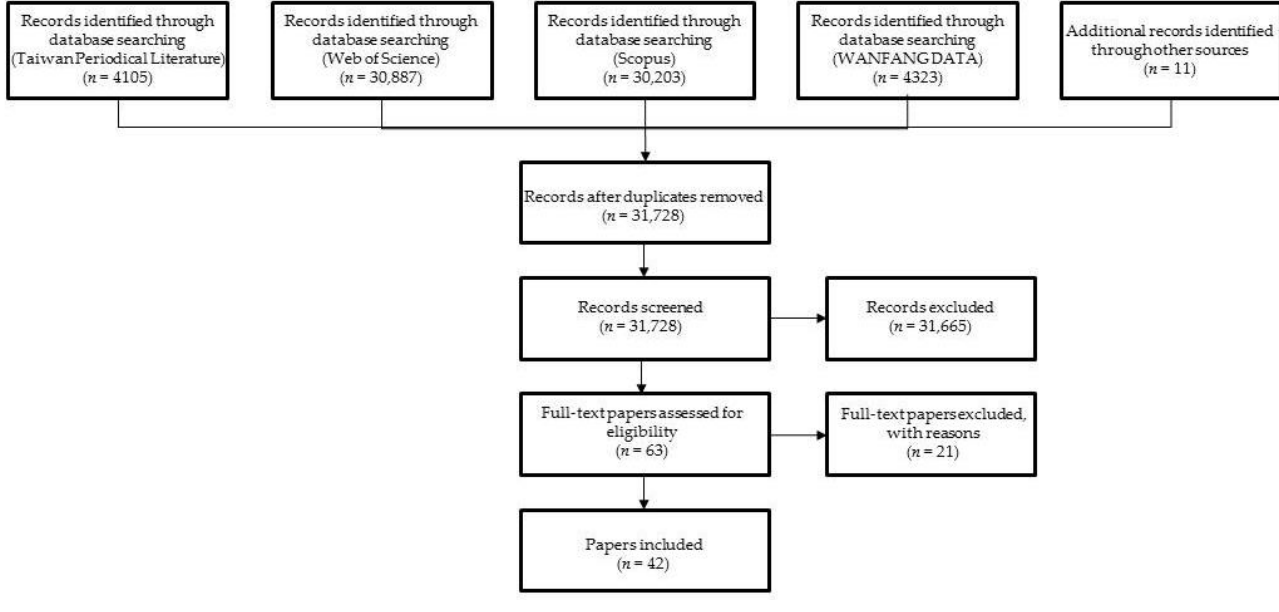
Table 1. Statistics of published journal articles in Chinese and English during consecutive 5 year periods. Publication Year